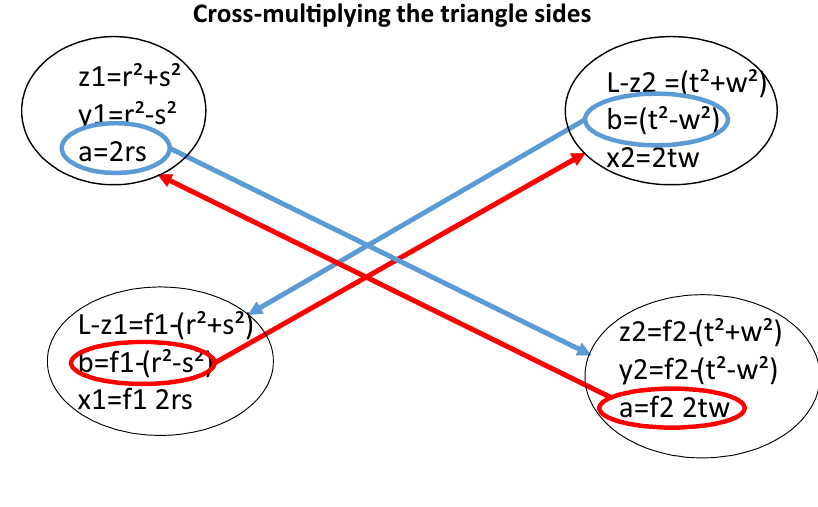
Figure 5. The cross-multiplying